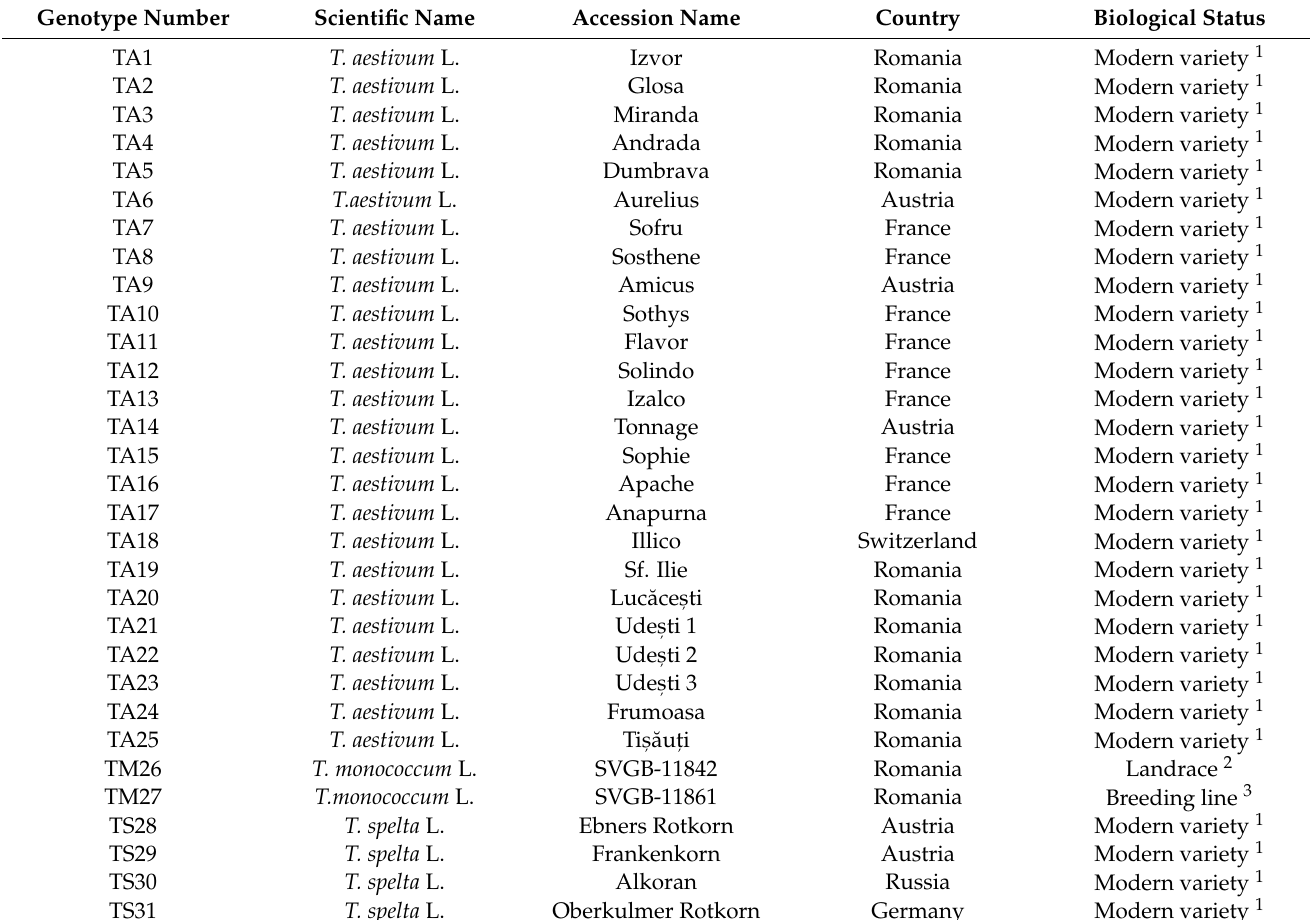
Table 1. Identification of genotypes regarding species, accession name, origin and biological